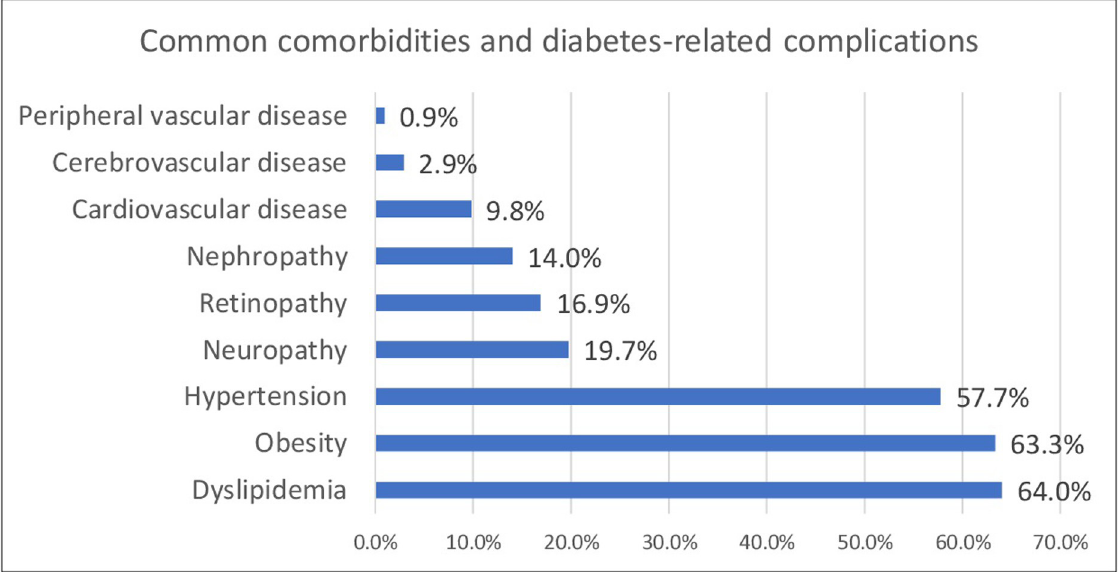
Fig 1. The prevalence of comorbidities and diabetes-related complications in patients with diabetes in Kuwait.